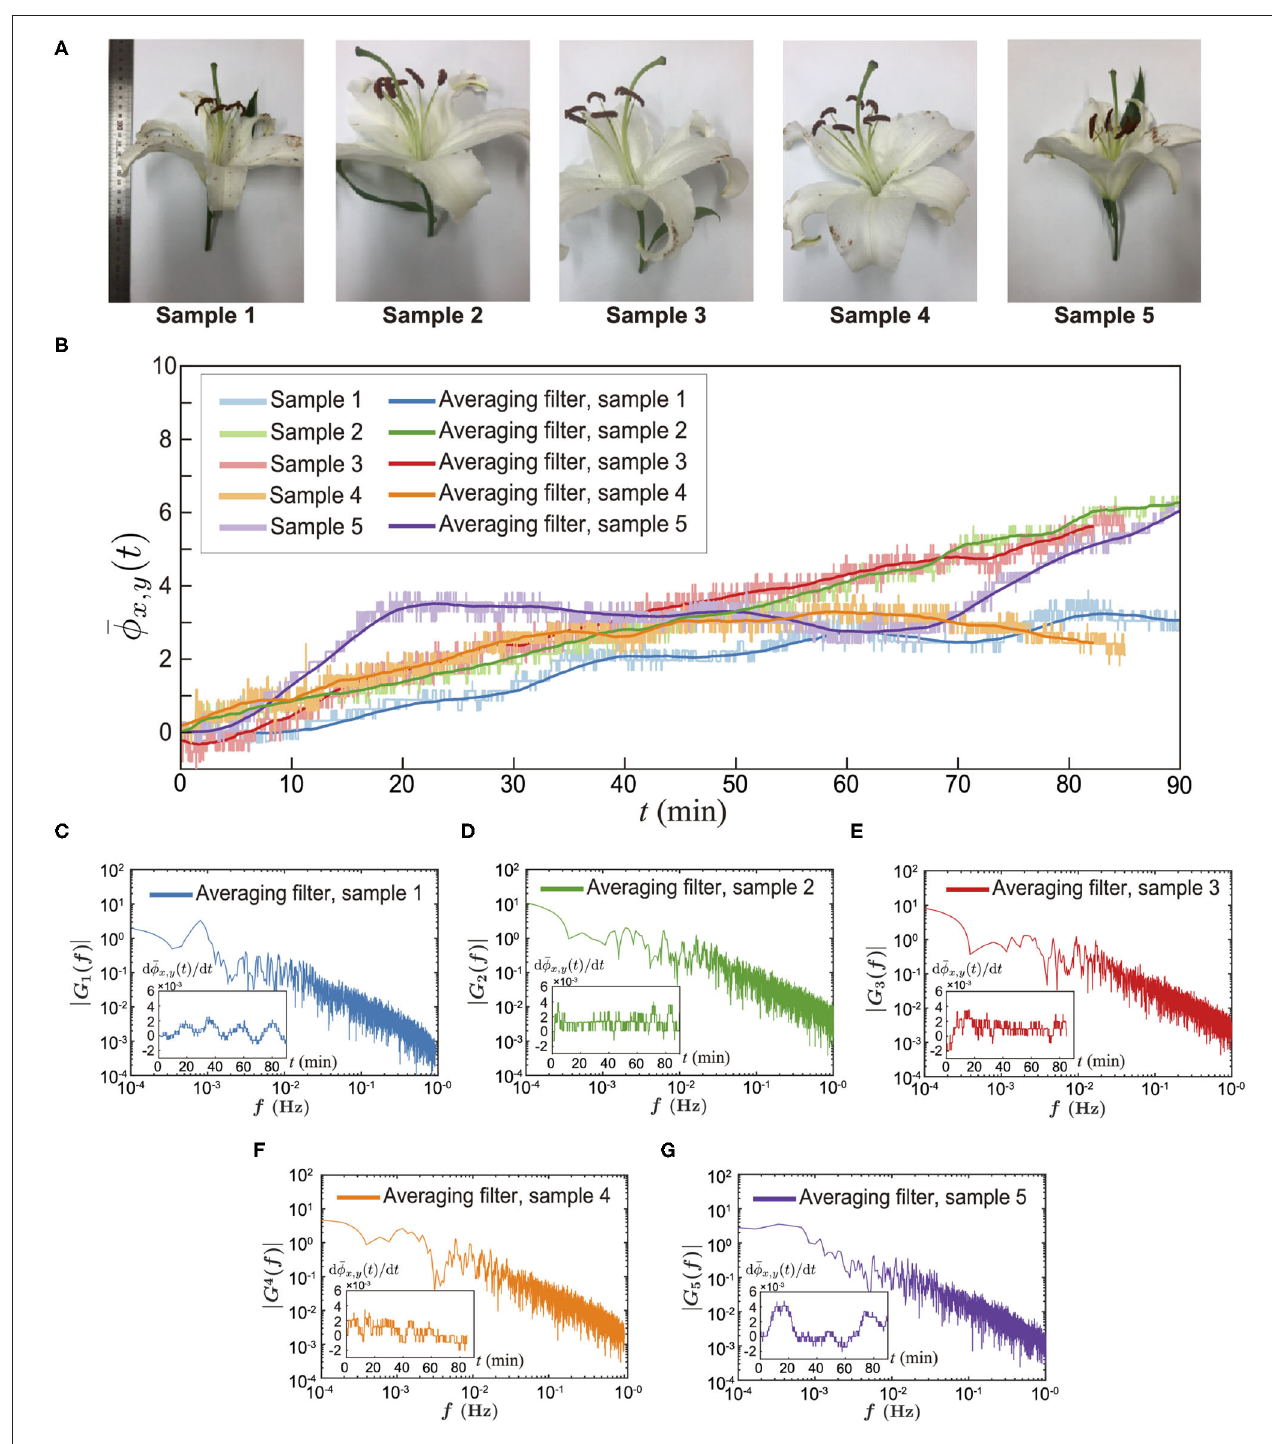
FIGURE 4 | Direct measurement of floral scents from alive lily. (A) Sample pictures. (B) Spatially averaged phase signal for 90 mins. The pastel colors are ¯ φ x , y ( t ) for different samples. The dark colors represent the averaged data using a spatial filter. (C–G) Amplitude spectrum results of the time-dependent net flux of the floral scent emission [d ¯ φ x , y ( t )/d t ], which were obtained from Fast Fourier Transforms (MATLAB subroutine FFT). The inset of each figure is a raw data of the time-dependent floral scent emission rate, d ¯ φ x , y ( t )/d t .